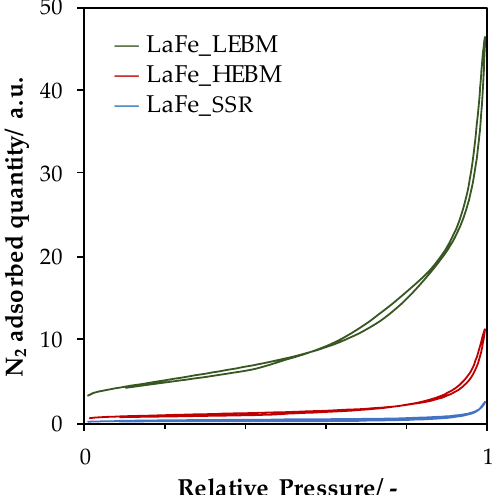
Figure 2. N 2 -Physisorption isotherms recorded for LaFeO 3 samples after each step of synthesis.